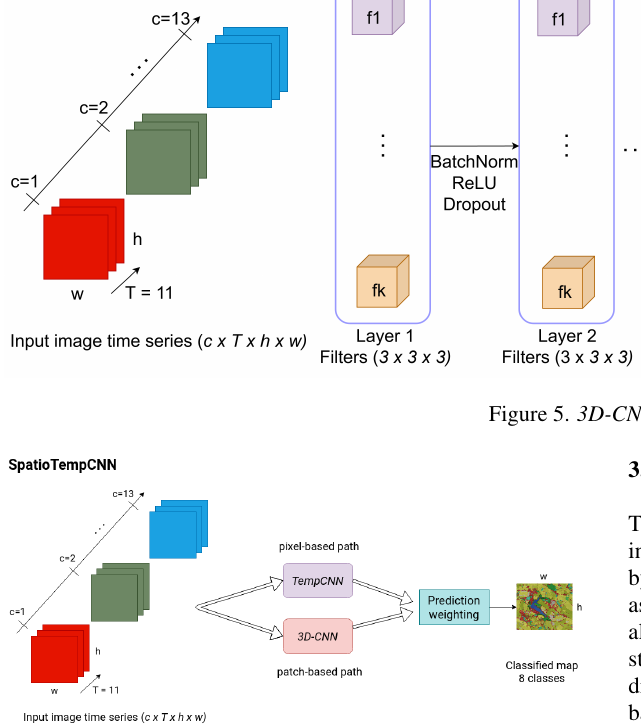
Figure 6. SpatioTempCNN: a two-stream model.